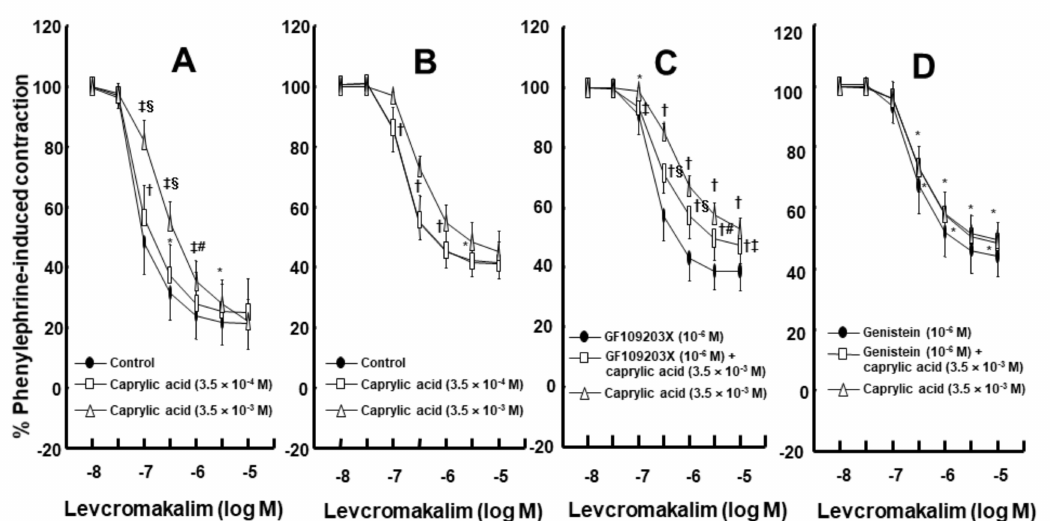
Figure 6. E ff ect of caprylic acid on the levcromakalim-induced vasodilation of isolated endothelium- intact ( A ; n = 12) and endothelium-denuded ( B ; control, 3.5 × 10 − 4 and 3.5 × 10 − 3 caprylic acid, n = 8, 7, and 8, respectively.) rat aortae ( A , B ). Data are shown as the mean ± SD and expressed as the percentage of the maximal contraction induced by phenylephrine (10 − 6 M). n indicates the number of isolated rat aortae. A: * p < 0.05, † p < 0.01 and ‡ p < 0.001 versus control. # p < 0.05 and § p < 0.001 versus caprylic acid (3.5 × 10 − 4 M). B: * p < 0.05, † p < 0.001 versus control. E ff ect of GF109203X, genistein and caprylic acid, alone and combined ( C : n = 8; D : n = 9), on the levcromakalim-induced vasodilation of endothelium-denuded rat aortae ( C , D ). Data are shown as the mean ± SD and expressed as the percentage of maximal contraction induced by phenylephrine (10 − 6 M). n indicates the number of isolated rat aortae. C: * p < 0.01 and † p < 0001 versus GF109203X alone. ‡ p < 0.05, # p < 0.01 and § p < 0.001 versus caprylic acid alone. D: * p < 0.001 versus genistein alone. − 5 Levcromakalim (10 M) induced membrane hyperpolarization in rat aortic vascular smooth muscle cells (VSMCs) (Figure 7A; p < 0.05 versus control; control: − 39.9 ± 6.3 mV versus levcromakalim: − 52.8 ± 9.7 mV). Lipofundin MCT / LCT (2%) did not significantly alter levcromakalim-induced − 3 membrane hyperpolarization (Figure 7A). However, a high concentration of caprylic acid (3.5 × 10 M) − 5 significantly inhibited the levcromakalim (10 M)-induced membrane hyperpolarization of rat aortic VSMCs (Figure 7B; p < 0.001 versus levcromakalim alone; levcromakalim: − 54.3 ± 4.9 mV versus caprylic acid plus levcromakalim: − 41.2 ± 4.3 mV). The potential values were corrected for a + 2 mV liquid junction potential at the 3M KCl / agar salt bridge. A change in membrane potential appeared within 1 min after treatment with